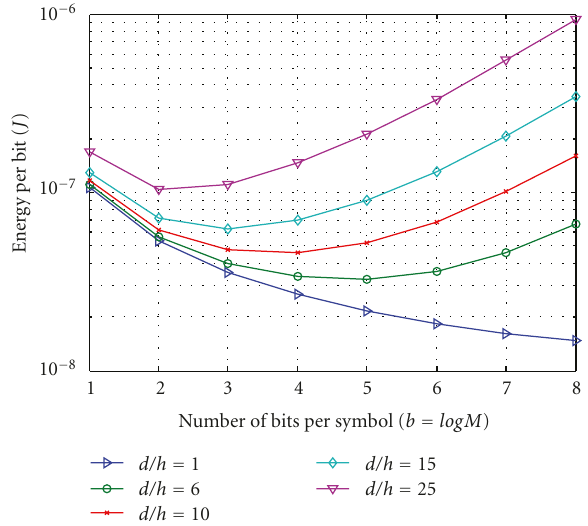
Figure 2: RF front-end transmission energy per bit versus modula- tion level b with di ff erent d / h (PAR = 5dB, and BER = 10–3).